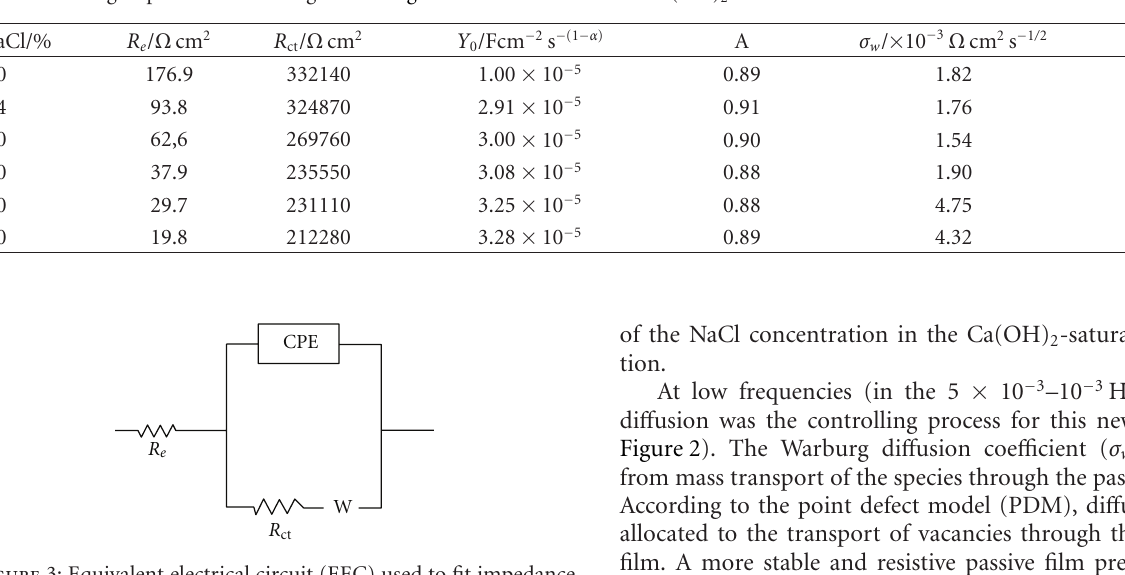
Table 3: Fitting impedance data using EEC of Figure 2 for low-nickel SS in Ca(OH) 2 -saturated solution with di ff erent NaCl concentrations.